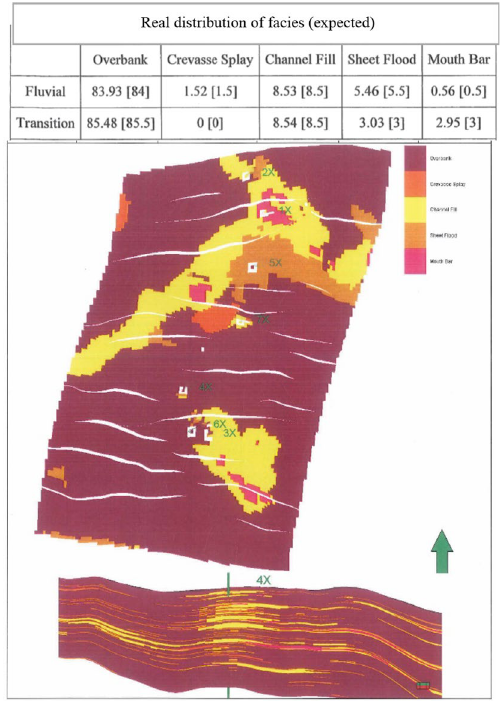
Fig. 27 Resulting model of case